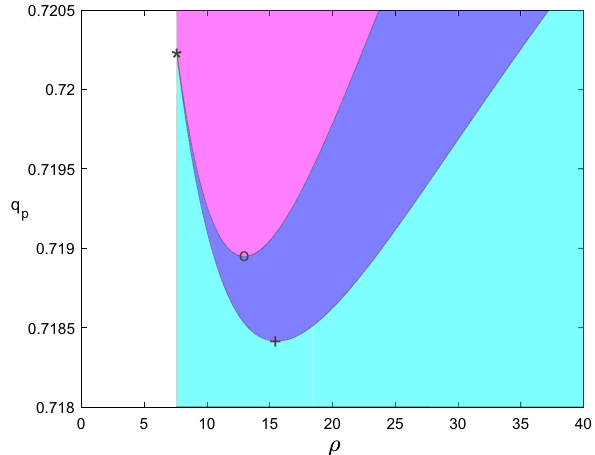
Fig. 1 The q p − ρ phase diagram with m 2 s = 0 and m 2 p = 3 / 4. The horizontal axis is the charge density ρ while the vertical axis is q p . The white region is dominated by the normal phase, the cyan region is dominated by the s-wave phase, the magenta region is dominated by the p-wave phase and the blue region is dominated by the s + p phase. The symbol ∗ marked the quadruple point, while the symbols o and + marked the two minimal points of two curves for the critical points of the s+pphase. The values of q p for thethree points are q ∗ p = 0 . 720234, q o p = 0 . 718949, q + p = 0 .